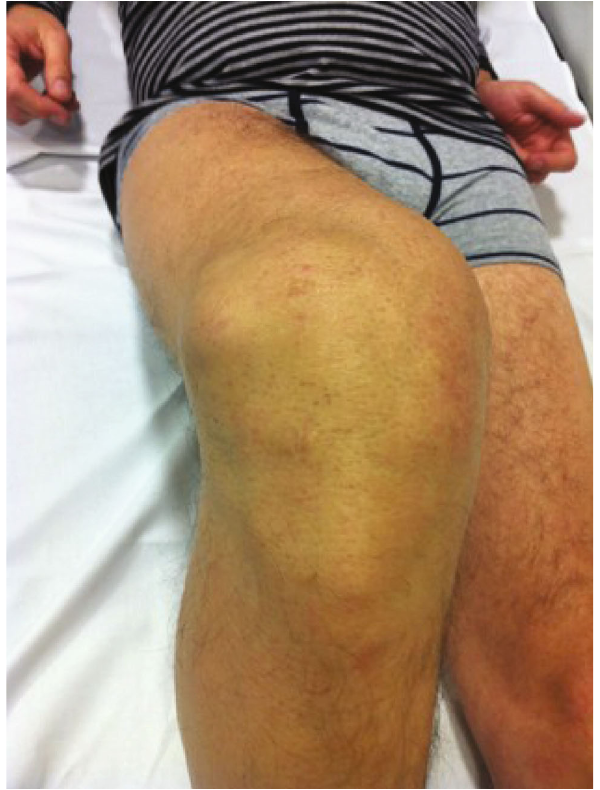
Figure 1: Swelling and cyst formation at the lateral aspect of the knee ten years after a noncomplicated ACL reconstruction. The cyst is underneath the skin incision that was made for the introduction of the crosspin device for femoral graft fi